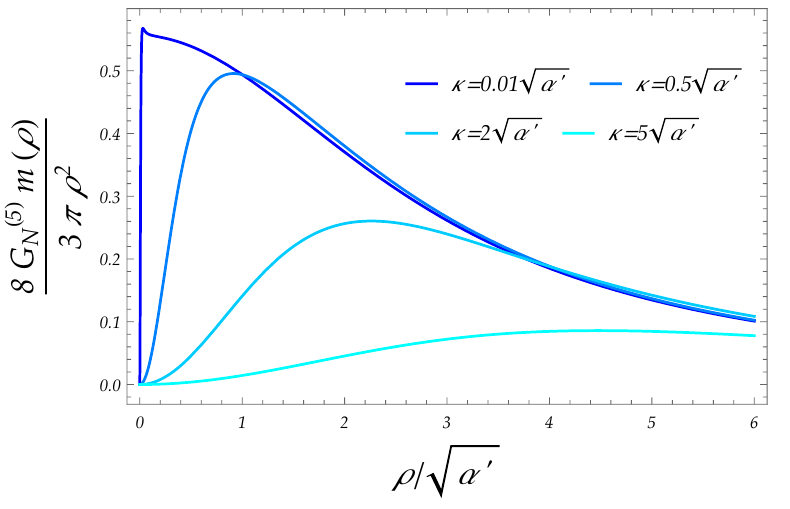
Figure 3 . Quotient between the radial mass function of the global instanton solution and the mass of the 5-dimensional Schwarzschild black hole for that Schwarzschild radius for di(cid:11)erent values of (cid:20) 2